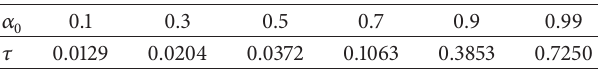
Table 1: The upper bounds of the delay (sampling period) for different values of 𝛼 0